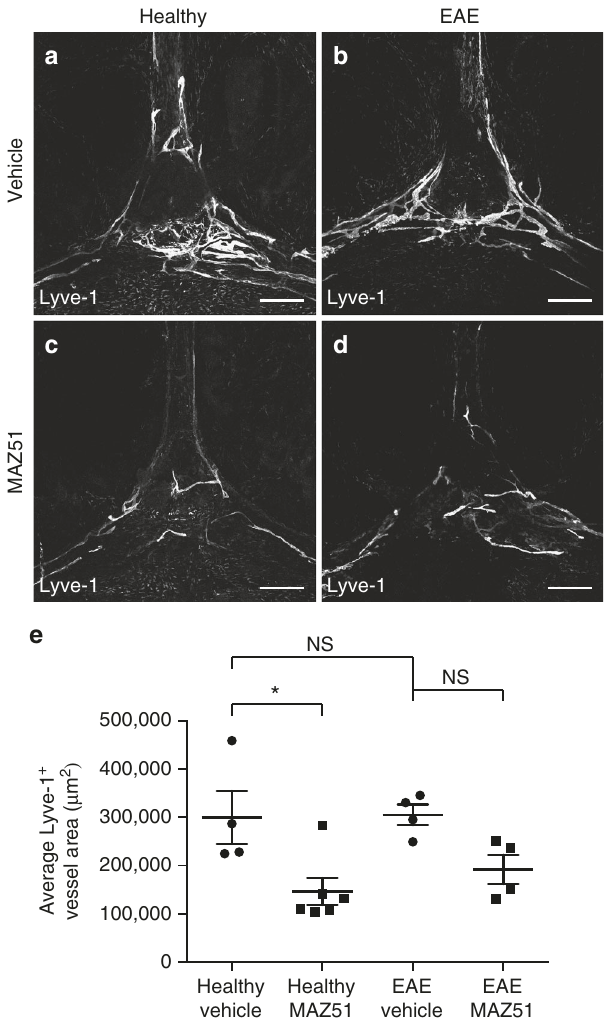
Fig. 5 Lymphangiogenesis is unique to the cribriform plate during EAE. a – d Healthy ( a , c ) and EAE Score 3.0 ( b , d ) wild-type mice were treated I.P. with either vehicle ( a , b ) or the VEGFR3 tyrosine kinase inhibitor MAZ51 ( c , d ) beginning on day 7 post-immunization and harvested at day 18 post- immunization. The meninges were collected and immunolabeled for Lyve-1 to visualize meningeal lymphatics. Scale bars = 500 µ m. e Quantitation of the average Lyve-1 + vessel area in the con fl uence of sinuses of the dura between vehicle and MAZ51 treated mice in both healthy and EAE (mean ± SEM; n = 4 – 6 mice per group; * p < 0.05, one-way ANOVA with